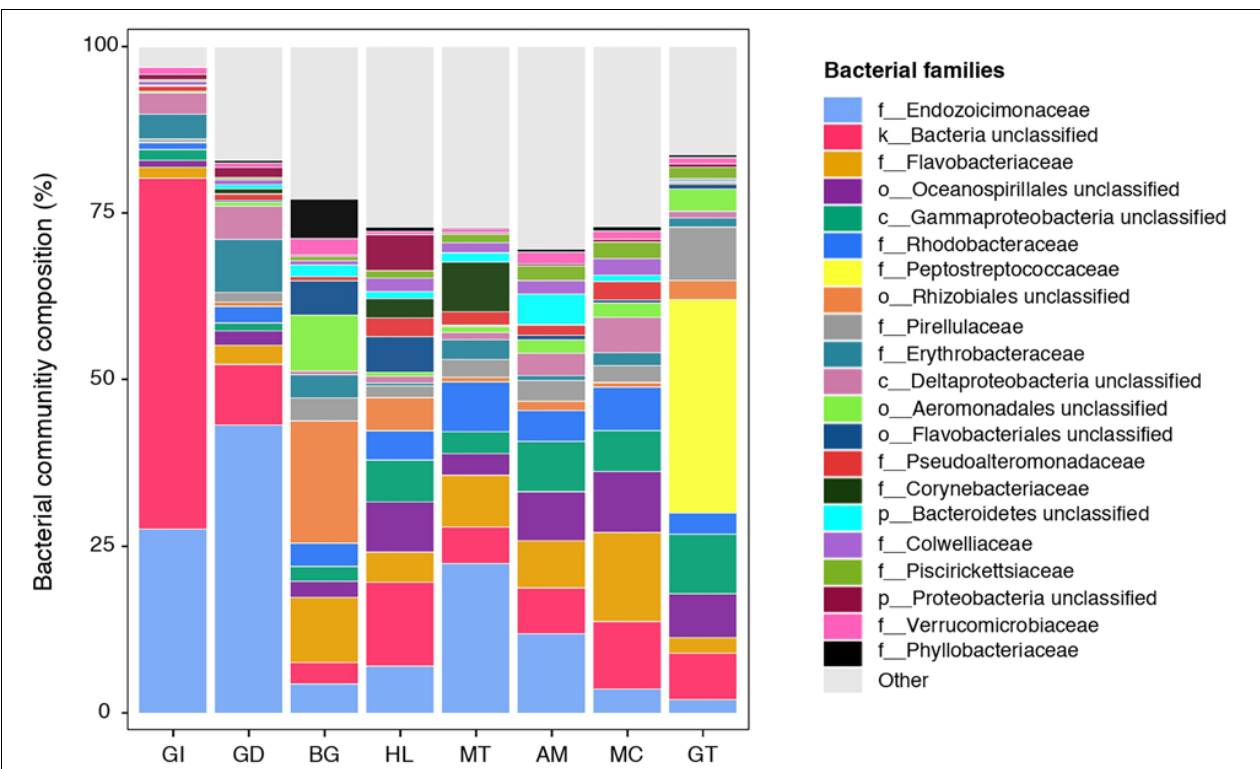
FIGURE 1 | Bacterial community composition of the pearl oyster Pinctada margaritifera . Average relative abundances of the most represented families are shown for each of the eight tissue types; gill (GI), gonad (GD), byssus gland (BG), haemolymph (HL), mantle (MT), adductor muscle (AM), mucus (MC), and gut (GT). Each colour represents a distinct family level OTU or lowest level available. The 21 dominant families are indicated. Less commun families were grouped as ‘Other’ and are shown in light